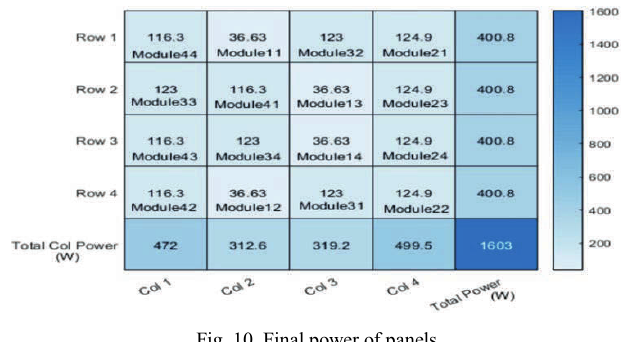
Fig. 10. Final power of panels.